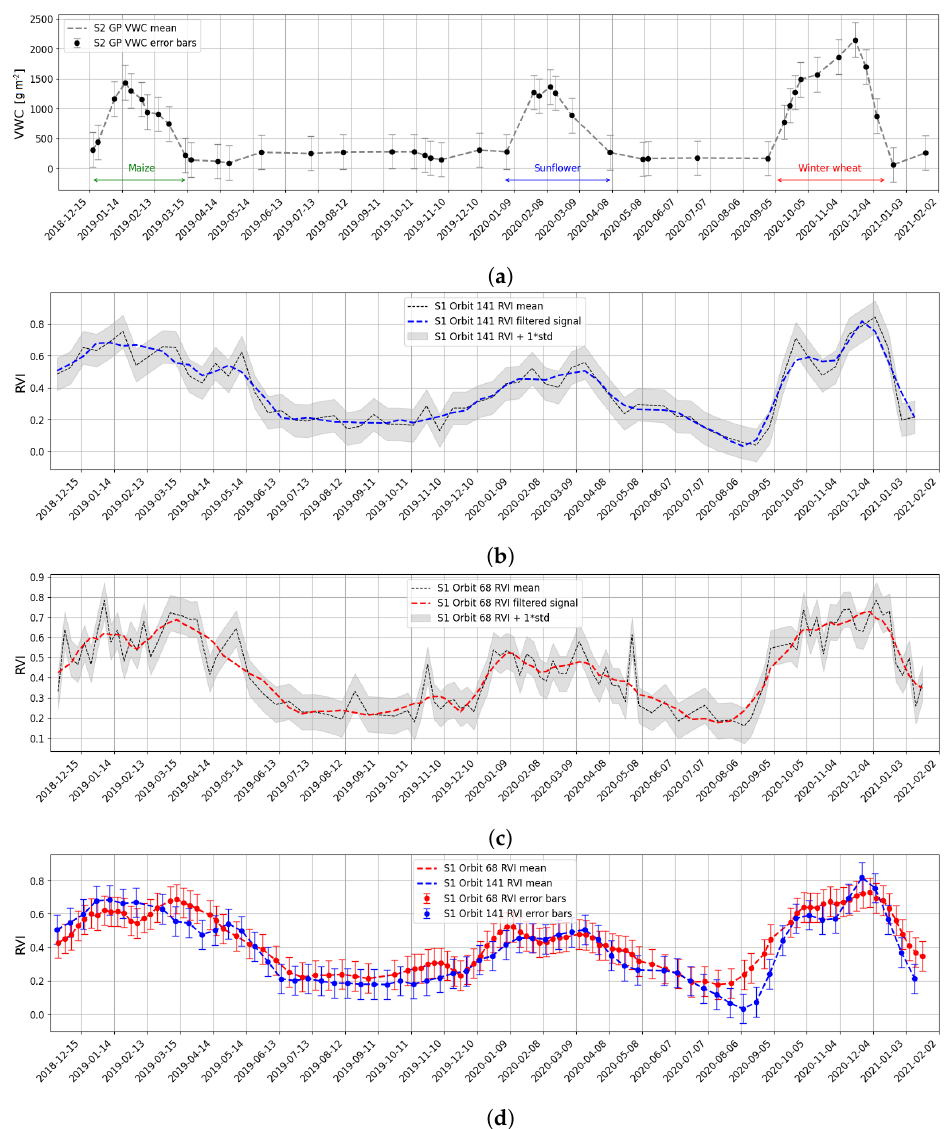
Figure 3. Temporal profiles (mean value and standard deviation) of averaged selected ROI-1 over a winter wheat parcel belonging to the BVCR 2020 crop campaign. S2 GP VWC time series from December 2018 to the end of January 2021 ( a ). S1 RVI orbit 141 smoothed (dashed blue line) and original (dashed black line) time series ( b ). S1 RVI orbit 68 smoothed (dashed red line) and original (dashed black line) time series ( c ). S1 RVI Orbit 68 (red line) and S1 orbit 141 (blue line) RVI time series ( d